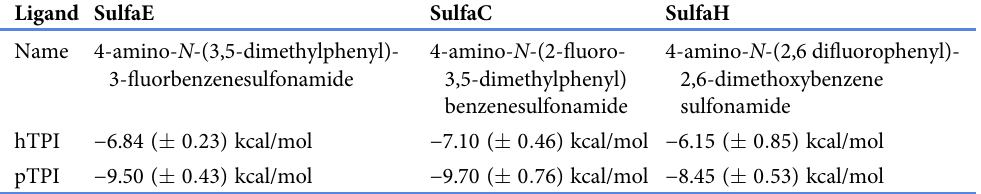
Table 1 Molecular docking binding energies between sulfonamides and hTPI/pTPI. Ligand